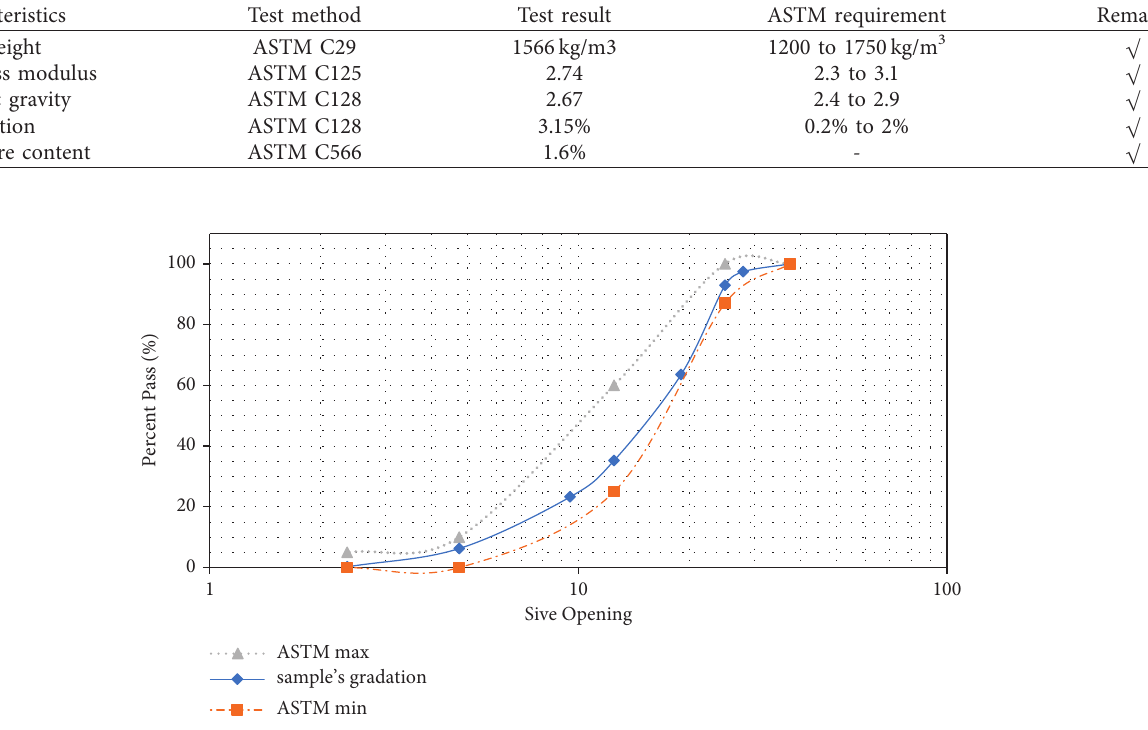
Figure 3: Coarse aggregate gradation curve with ASTM limits. Table 3: Properties of coarse aggregate used in this